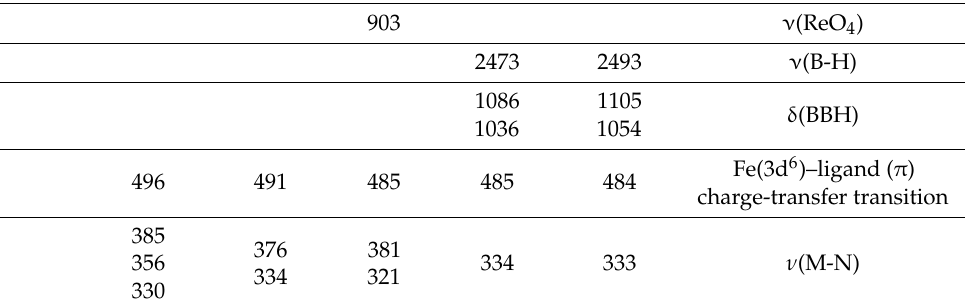
Table 4. Parameters of diffuse reflectance spectra.